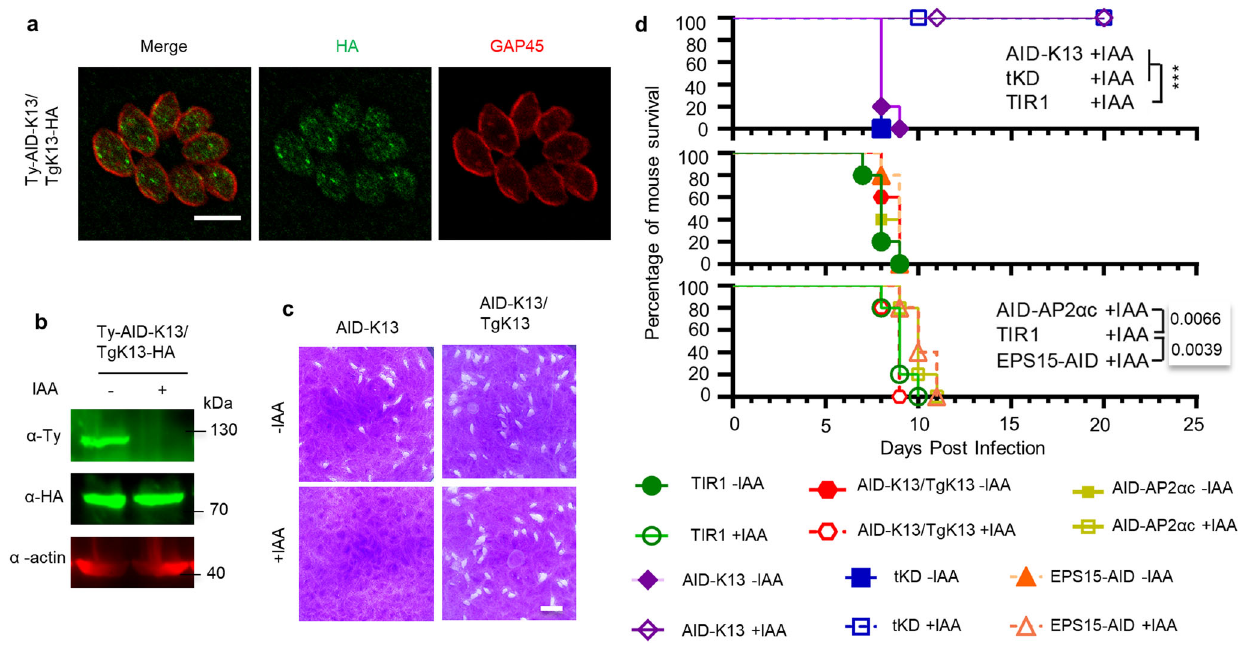
Fig. 7 | Kelch13 is essential for parasite virulence in mice. a , b IFA and western blotdetectionofcomplementedHA-TgKelch13intheAID-Kelch13linebygrowthin ±IAAfor24h.Actinservedasacontrol.Scalebar=5 μ m. c Plaqueformationbythe AID-K13 and complementation lines grown in ±IAA for 7 days. Scale bar=0.5cm. d Survival of mice infected with TIR1, AP2 α c-AID, EPS15-AID, AID-K13, tKD and the complementation line (AID-K13/TgK13) in the absence (with vehicle) and presence